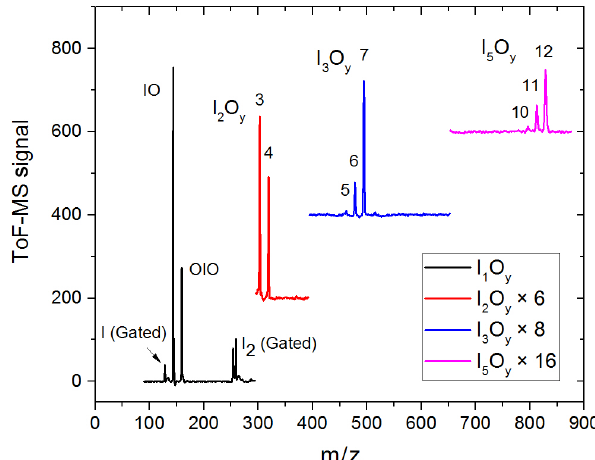
tions, measurements are taken until three concordant results are obtained (typically the first three results).